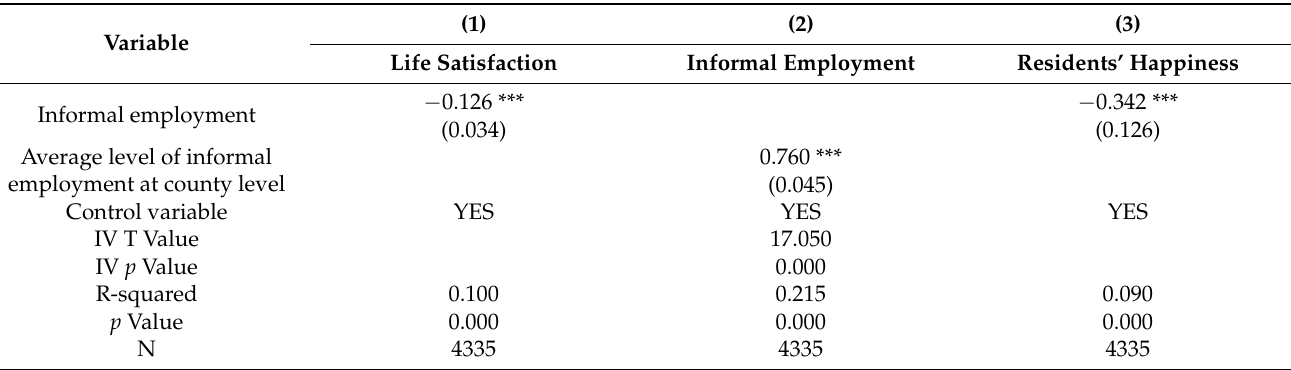
Table 6. Results of the robustness